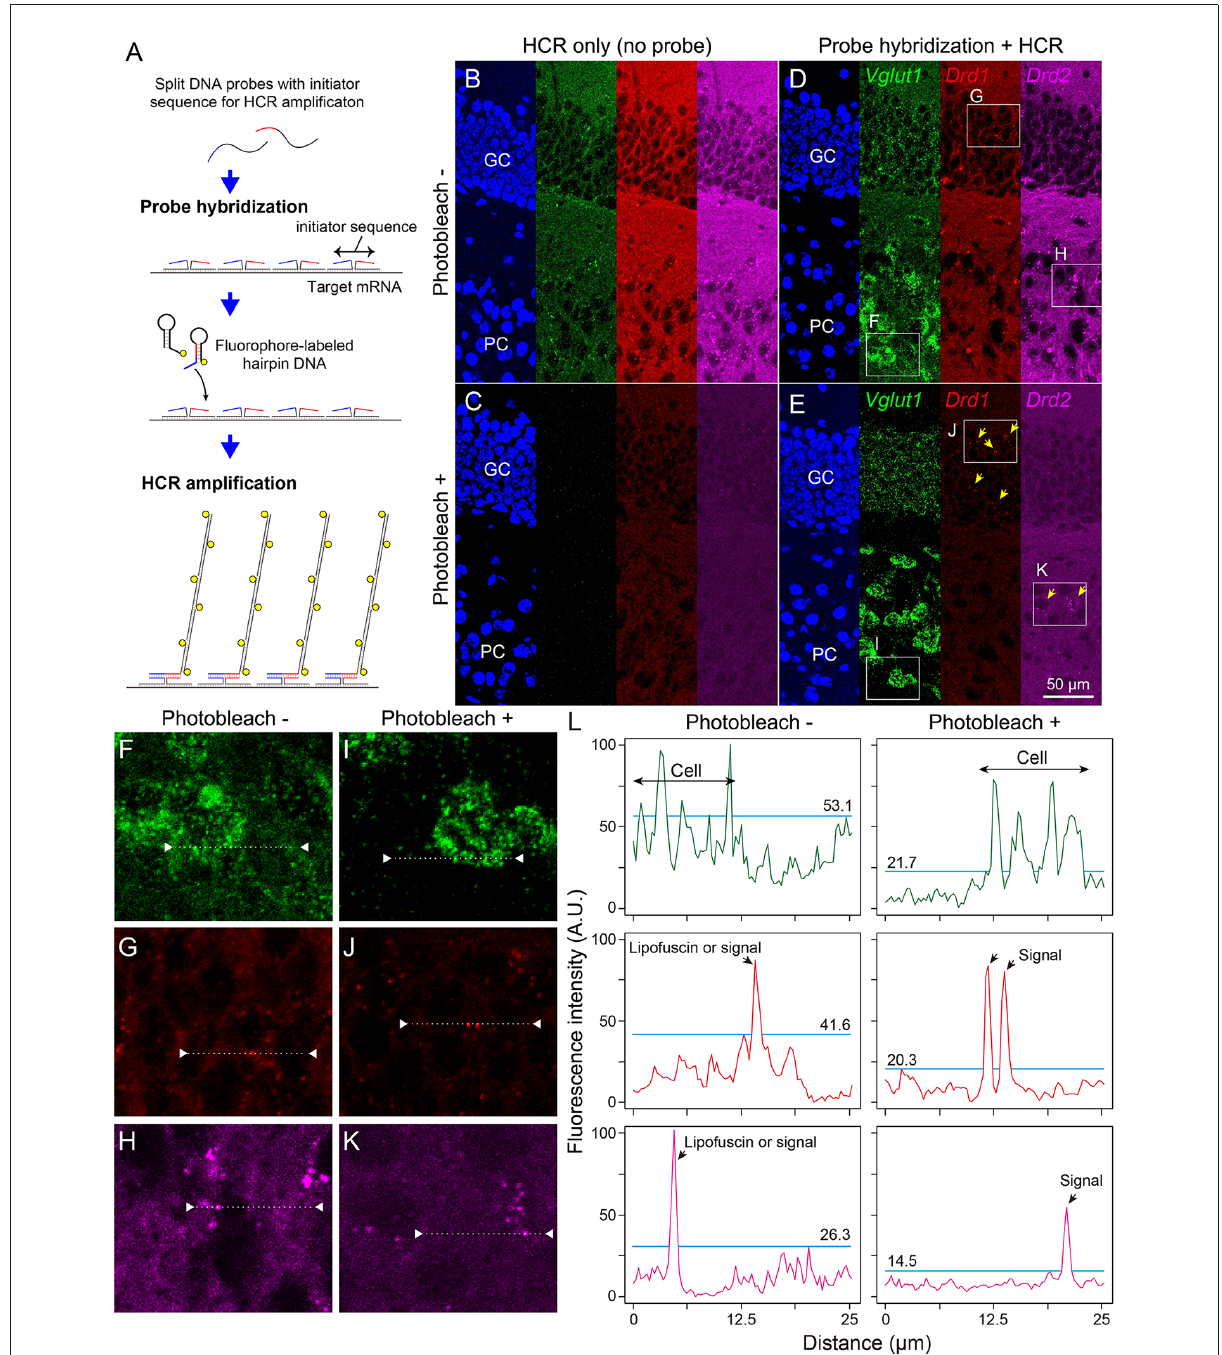
FIGURE3 Effect of photobleaching on the signal/noise ratio of ISH-HCR staining. (A) Schematic drawings describing ISH-HCR staining in this study. ISH-HCR consists of two steps: hybridization of split DNA probes and HCR amplification of fluorophore-labeled hairpin DNAs. HCR amplification starts only in the case that both split probes are hybridized with target mRNA. In the HCR amplification step, a pair of fluorophore-labeled hairpin DNAs polymerize on the hybridized probes with complete initiator sequences. For details, see Tsuneoka and Funato (2020). (B–E) Representative photomicrograph of ISH-HCR staining for Vglut1 (green), Drd1 (red), and Drd2 (magenta) mRNAs in addition to Hoechst 33342 nuclear staining (blue) in the dentate gyrus of the mouse hippocampus. No probe control without photobleaching (B) and with photobleaching (C) . ISH-HCR staining of Vglut1 , Drd1 , and Drd2 without photobleaching (D) and with photobleaching (E) . Arrows indicate Drd1 - or Drd2 -positive cells. Scale bar: 50 µ m. GC, granule cell layer; PC, polymorph cell layer. (F–K) Magnified views indicated by rectangles in (D,E) . (L) Line profile of fluorescent intensity indicated by dotted lines and triangles on (F–K) . Light blue lines indicate the maximum intensity of background signals. Fluorescence intensities are shown as arbitrary units